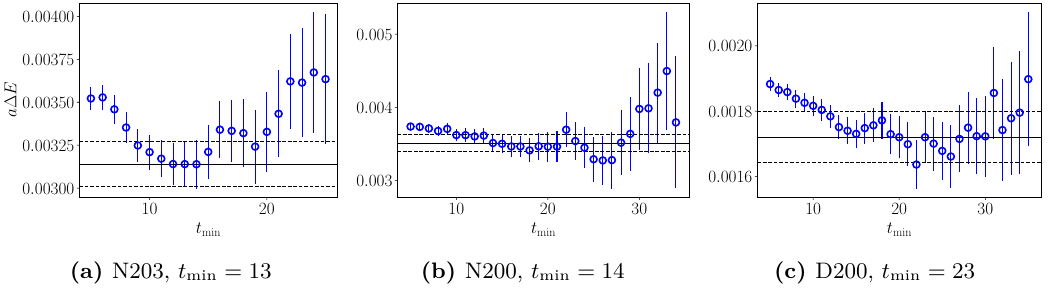
Figure 2. The extracted energy shift in the lab frame as a function of the smallest time separation included in the fit, t min , for the three-kaon A 2 (9) ground state energy on each ensemble. The fits are to the correlator ratio, and a single-exponential is used for the model. The central value and error of the energy shift for the chosen fit is indicated with the horizontal black solid and dashed lines,